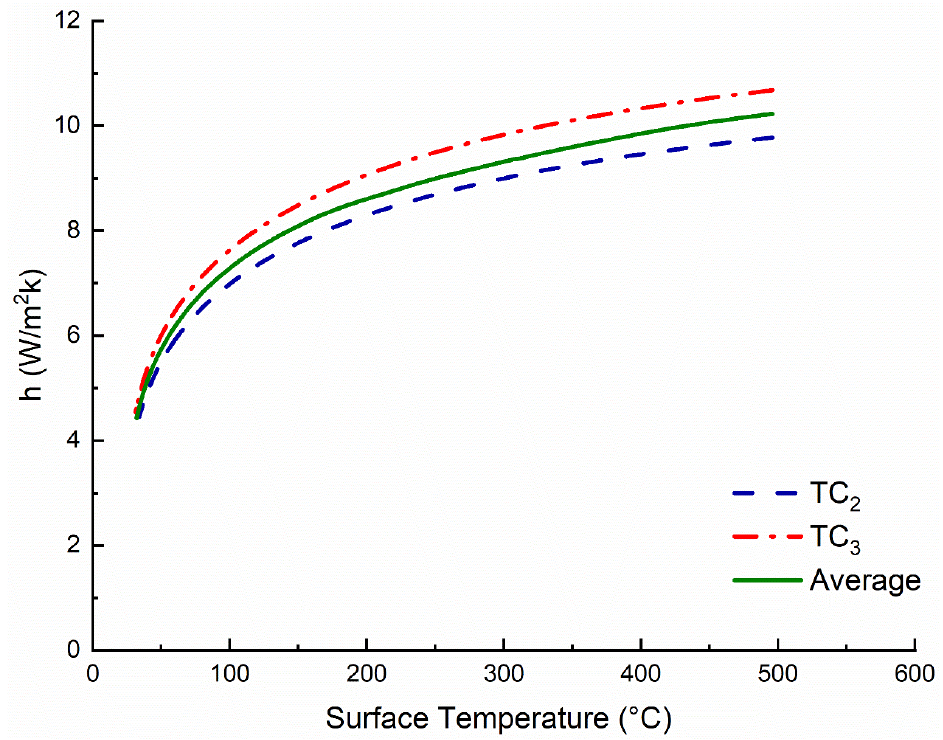
Figure 2. The heat transfer coefficients of the air-cooled part of the block at the locations TC 2 and TC 3 and their average vs. surface temperature .